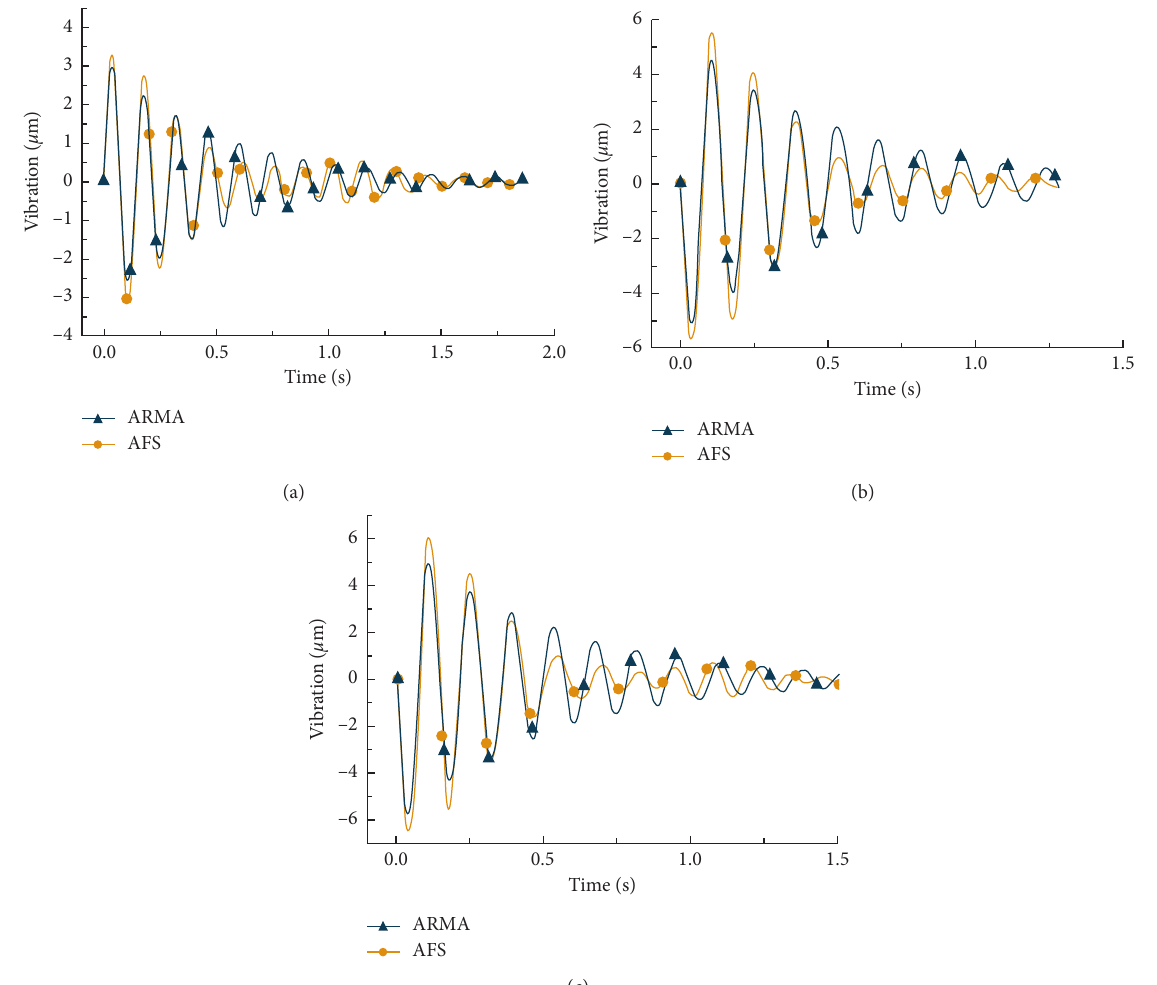
Figure 9: ARMA recognition results of triangle move profile impact with V